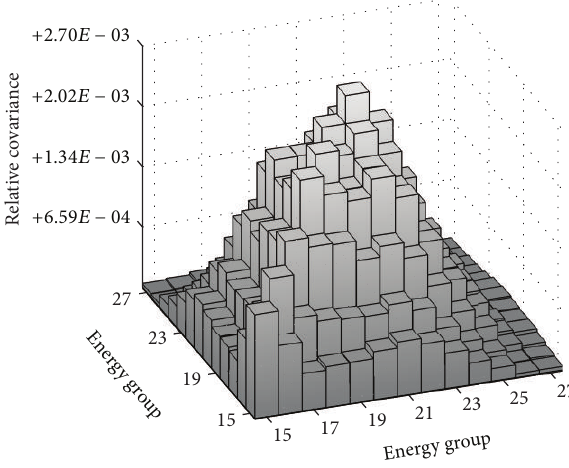
Figure 10: 𝜎 U 238 𝛾 covariance at 𝜎 0 = 10𝑏 .